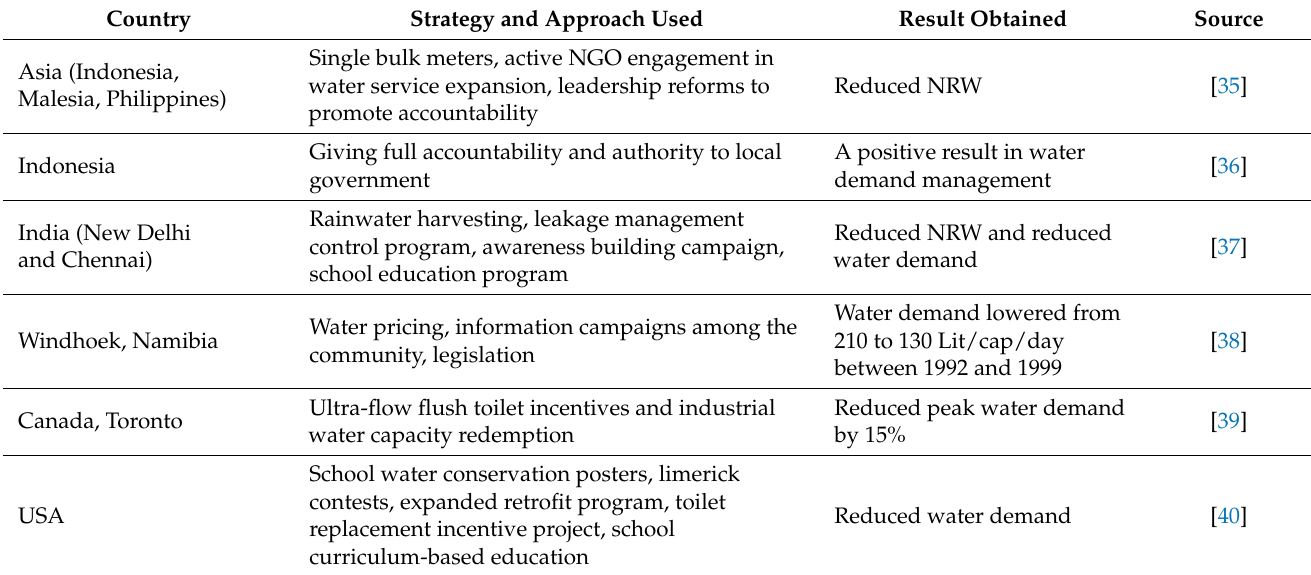
Table 1. Reviewed studies on strategies for water demand